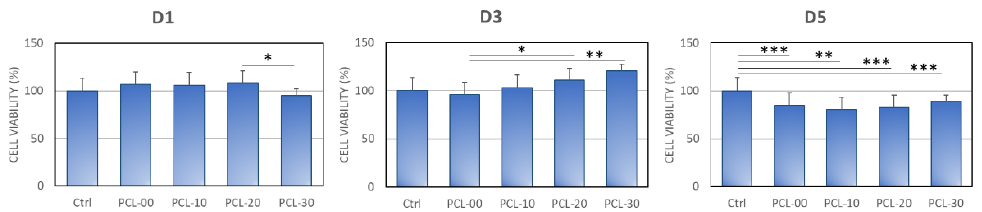
Figure 6. MG63 cell viability when cultured in PCL/ β -TCP extraction medium for 1, 3, and 5 days. Significant differences are indicated by *, p < 0.05, **, p < 0.01 and ***, p < 0.001 .